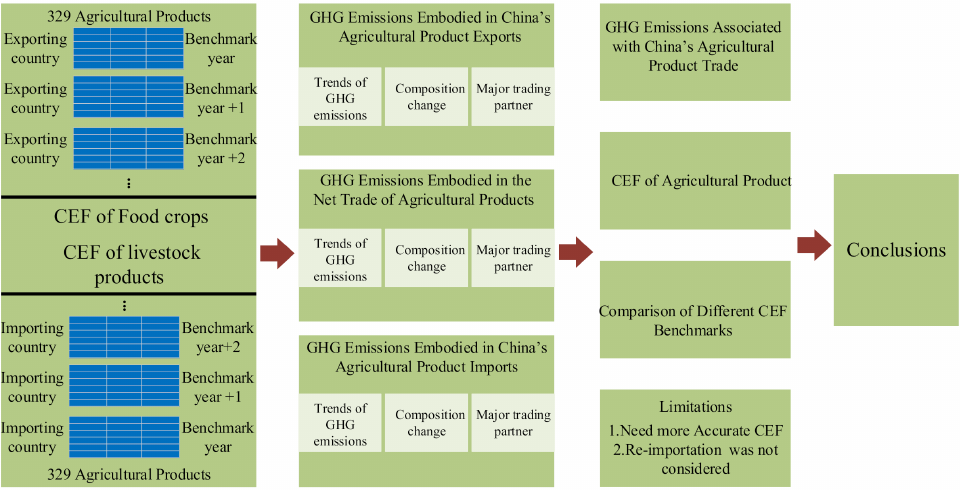
Figure 1. Research framework of this